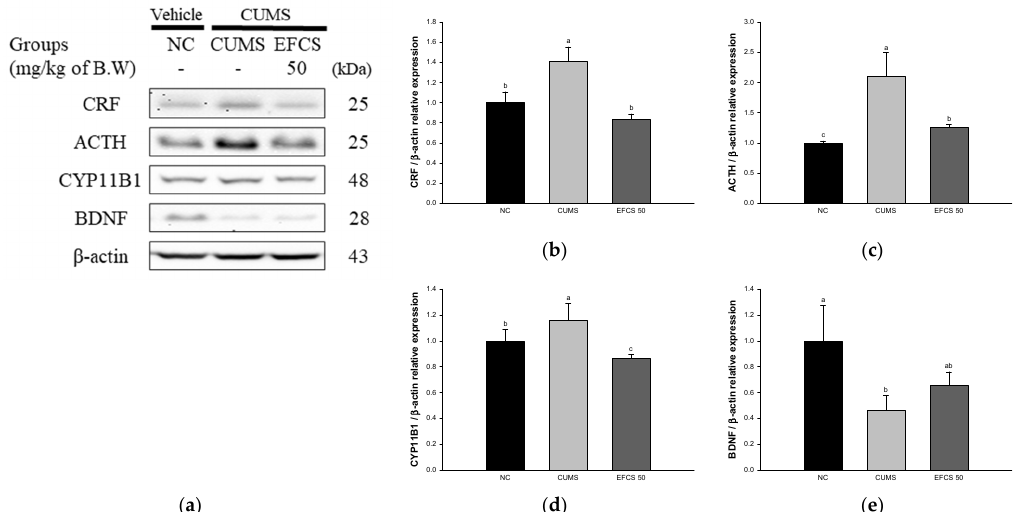
Figure 7. Effect of ethyl acetate fraction from Cedrela sinensis (EFCS) on CUMS-induced stress pathway in brain tissue. Western blot images ( a ), protein expression levels of CRF ( b ), ACTH ( c ), CYP11B1 ( d ), and BDNF ( e ) in brain tissues. Results shown are mean ± SD ( n = 3). Data are statistically considered at p < 0.05, and different lowercase letters indicate statistical significance. Means with the same letter are not significantly different.